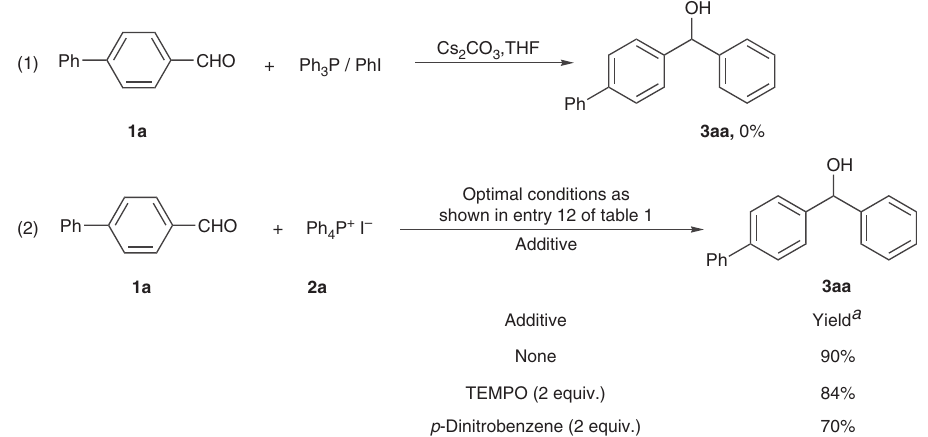
Figure 2 | Mechanistic experiments. (1) The use of Ph 3 P/PhI system instead of salt 2a failed to convert aldehyde 1a into product 3aa . (2) Neither radical scavenger TEMPO nor single-electron-transfer inhibitor p -dinitrobenzene can obviously suppress the phenylation reaction. a